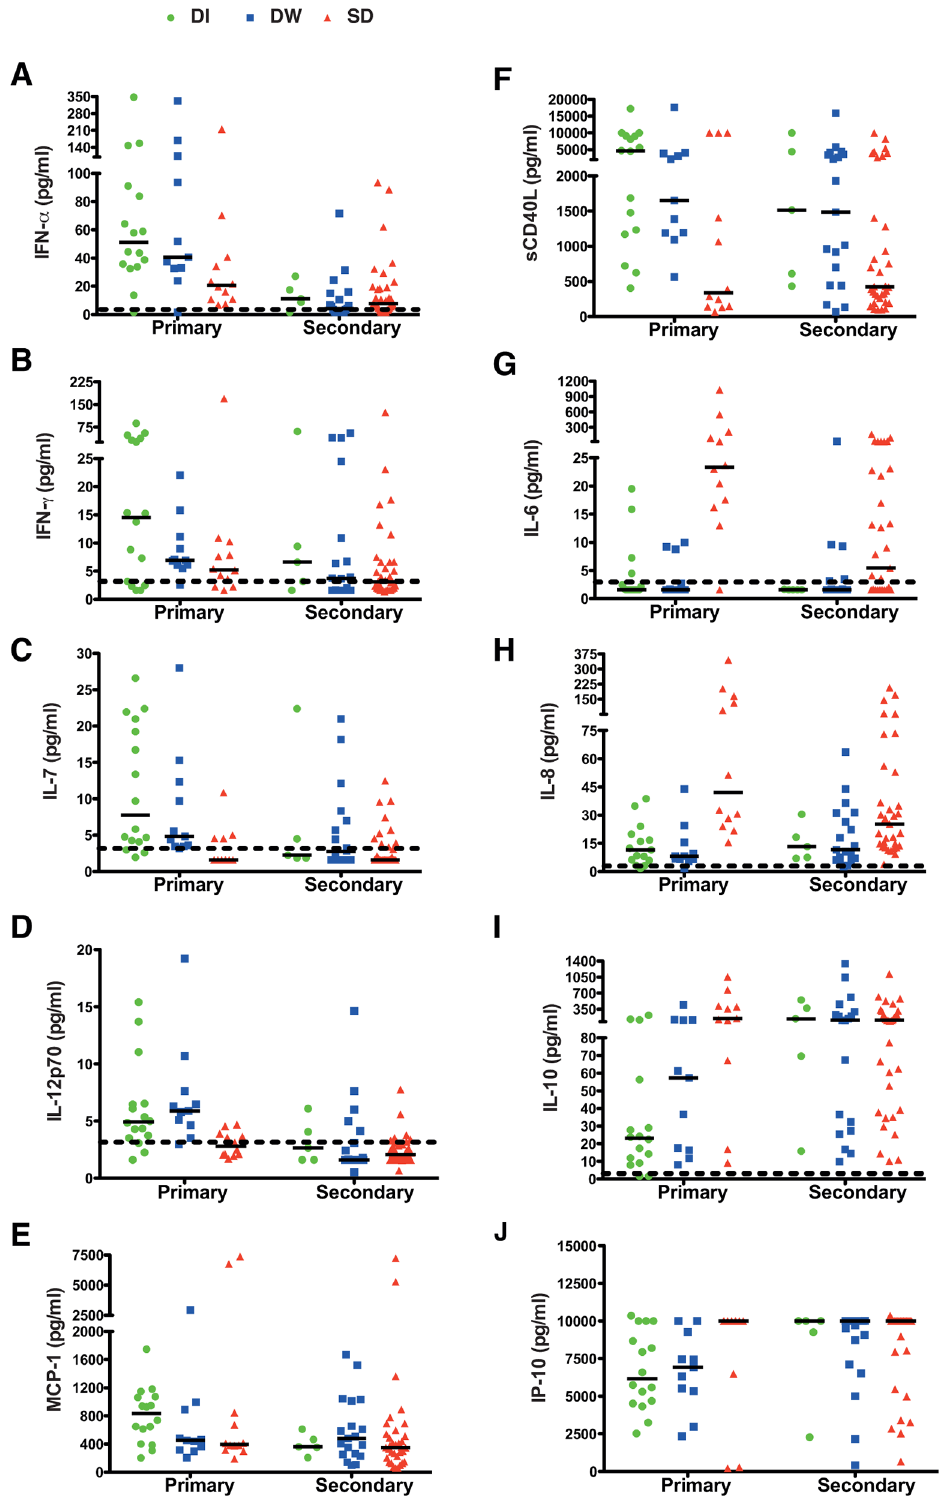
Fig 5. Cytokine profile in patients with primary and secondary infections Plasma cytokine/chemokine/ inflammatory mediator levels in the plasma of primary and secondary dengue infection with indicated severities. (A) IFN- α (B) IFN- γ (C) IL-7, (D) IL-12p70, (E) MCP-1, (F) sCD40L (G) IL-6 (H) IL-8, (I) IL-10 and (J).IP-10. Median values are indicated by the bar. Dotted line represents the limit of